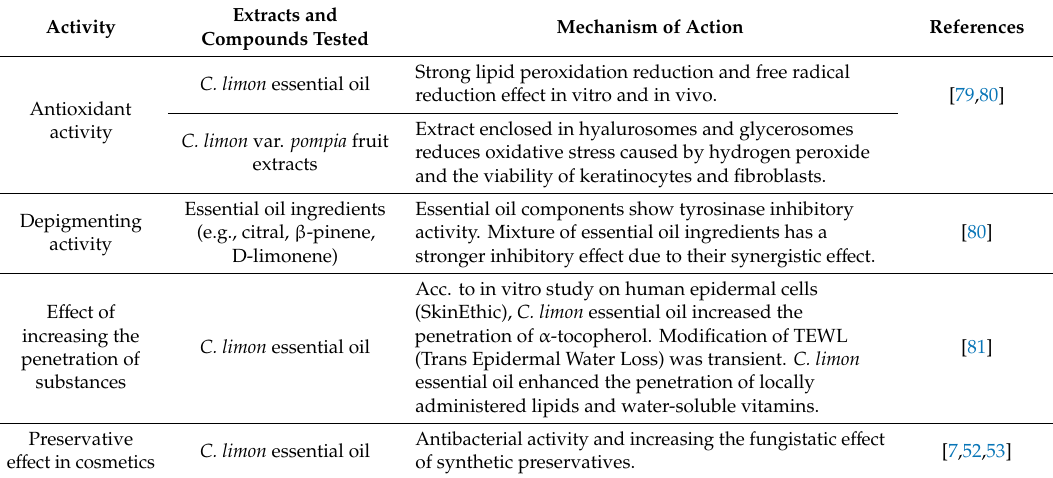
Table 9. Biological activity of C. limon fruit extracts, essential oil and its ingredients compounds significant from the cosmetics point of view, confirmed by scientific research.